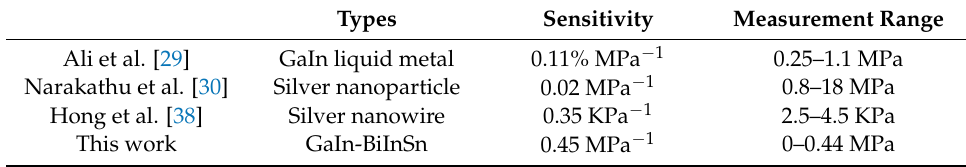
Table 3. Comparison of PDMS dielectric-based capacitive pressure